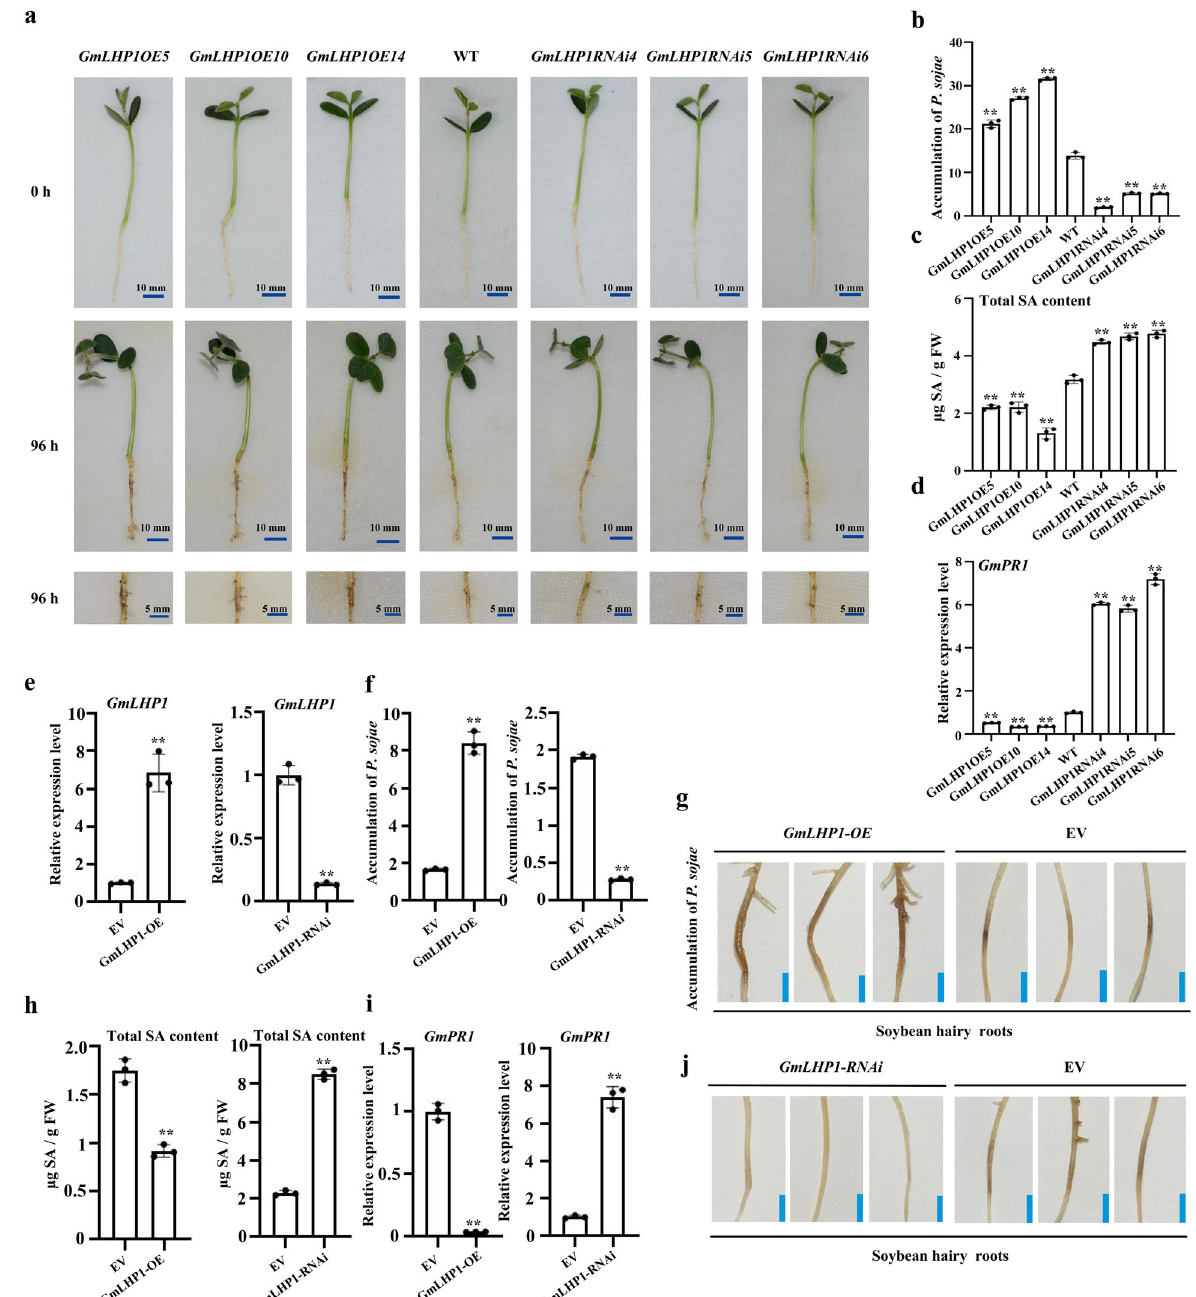
Fig. 3 GmLHP1 negatively regulates plant immunity. a Disease symptoms in the roots of wild-type (WT), GmLHP1OE , and GmLHP1RNAi soybean plants at 96 h after inoculation with P. sojae . b Relative biomass of P. sojae in WT, GmLHP1OE , and GmLHP1RNAi soybean plants based on P. sojae TEF1 (EU079791) transcript levels. c SA contents in leaves of transgenic and WT soybean. FW, fresh weight. d Relative GmPR1 expression levels in transgenic and WT soybean plants. The expression level of the control sample (WT plants) was set to 1. e qRT-PCR analysis of relative GmLHP1 expression in transgenic soybean hairy roots. Empty vector (EV) transgenic hairy roots were used as controls, and the expression level of the control sample (EV) was set to 1. f Relative biomass of P. sojae in GmLHP1- transgenic hairy roots based on P. sojae TEF1 (EU079791) transcript levels. g Typical infection symptoms of GmLHP1-OE and EV soybean hairy roots at 48 h after P. sojae inoculation. Bars, 0.5 cm. h SA contents in GmLHP1-OE , GmLHP1- RNAi , and EV hairy roots. FW, fresh weight. i Relative GmPR1 expression levels in GmLHP1-OE , GmLHP1-RNAi , and EV hairy roots. The expression level of the control sample (EV) was set to 1. j Typical infection symptoms of GmLHP1-RNAi and EV hairy roots at 48 h after P. sojae inoculation. Bars, 0.5 cm. The housekeeping gene GmEF1 was used as an internal control to normalize the data. The experiment was performed on three biological replicates, each with three technical replicates, and the results were statistically analyzed using Student ’ s t -test (* P < 0.05, ** P < 0.01). Bars indicate the standard deviation of the mean ( n = 3).